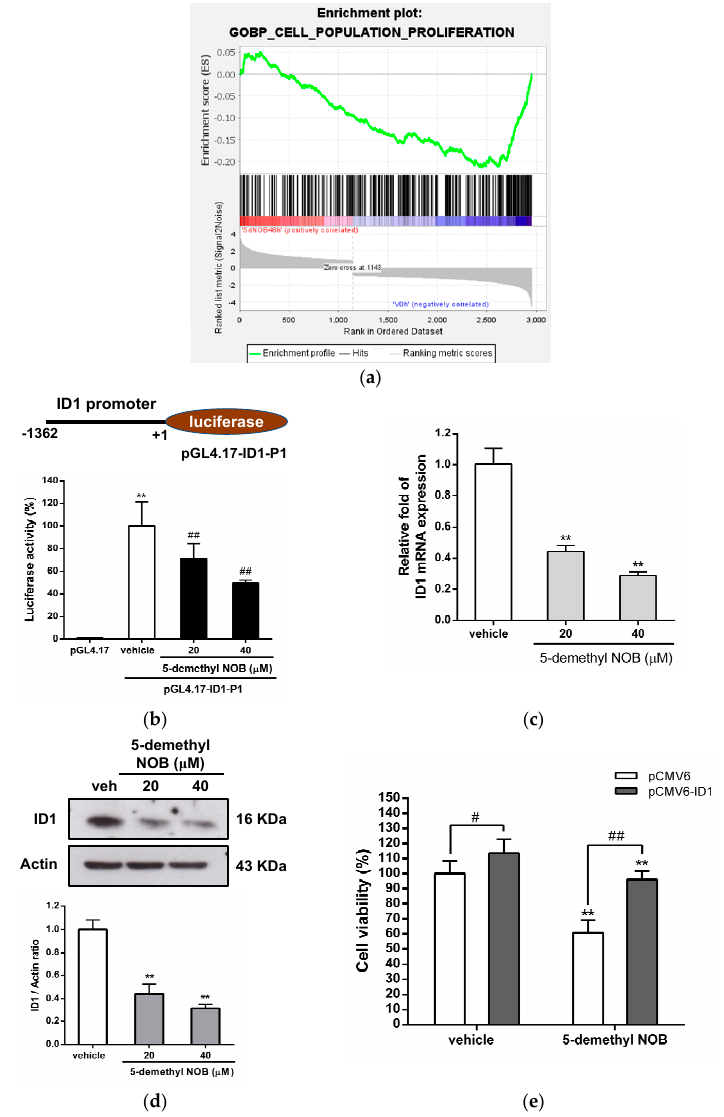
Figure 6. Gene set enrichment analysis (GSEA) and ID1 gene expression in 5-demethyl NOB-treated THP-1 cells. ( a ) GSEA demonstrates that the GO BP signature “Enrichment plot: GO BP Cell Population Proliferation” (GO: 0008283) gene set is enriched with the DEGs of 5-demethyl NOB-treated cells. The barcode plot shows the position of the genes in the gene set. ( b ) The pGL4.17 vector or ID1 promoter-luciferase plasmid (pGL4.17-ID1-P1) and the Renilla luciferase control plasmid were co-transfected into THP-1 cells for 24 h. These cells were then treated with vehicle or 5-demethyl NOB (20 and 40 µ M) for 24 h. Luciferase activity was measured and normalized to the Renilla control. The data represent the mean ± SD of three independent experiments. ** p < 0.01 represents significant differences compared to the control vector-transfected group. ## p < 0.01 represents significant differences compared to the vehicle group. ( c ) THP-1 cells were treated with vehicle or 5-demethyl NOB (20 and 40 µ M) for 48 h, and ID1 mRNA levels were determined by RT–qPCR analysis. ( d ) Western blot analysis of ID1 and actin proteins. The experiments were performed in triplicate, and a representative blot is shown. The intensity of ID1 versus actin protein was normalized. The data represent the mean ± SD of three independent experiments. ** p < 0.01 represents significant differences compared to the vehicle group. ( e ) The pCMV6 control vector or pCMV6-ID1 expression plasmid was transfected into THP-1 cells for 24 h followed by treatment with vehicle or 5-demethyl NOB (40 µ M) for 48 h. Cell viability was measured by MTT assay. The viability of the vehicle- treated group (pCMV6-transfected cells) was expressed as 100%. # p < 0.05 and ## p < 0.01 represent a significant difference compared to the 5-demethyl NOB-treated pCMV6-transfected